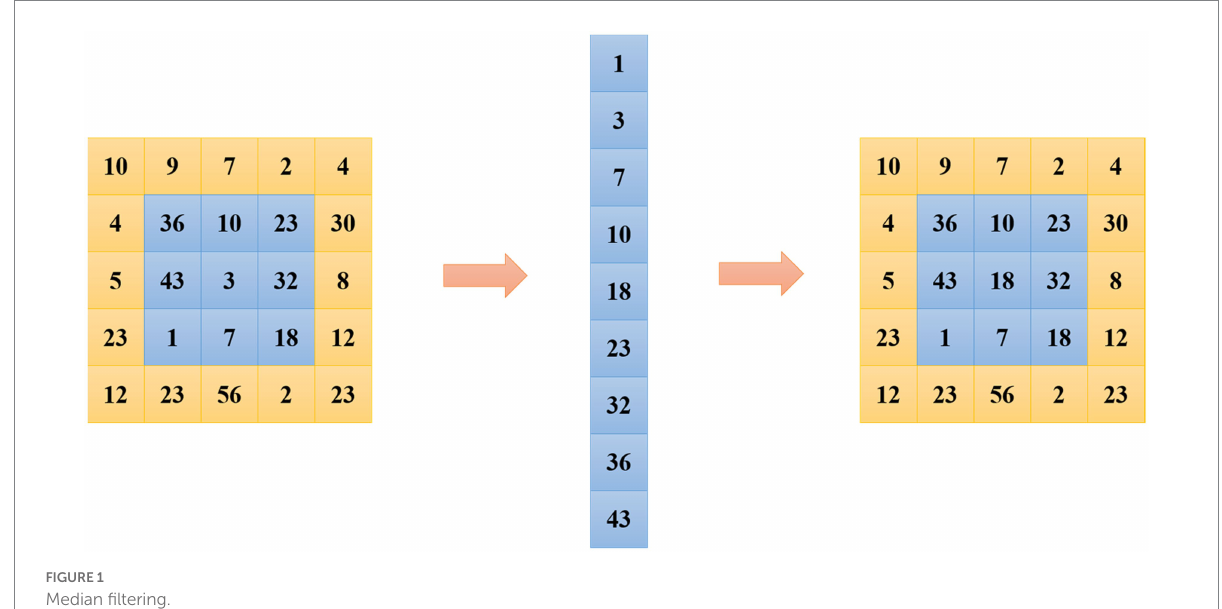
FIGURE 1 Median filtering.